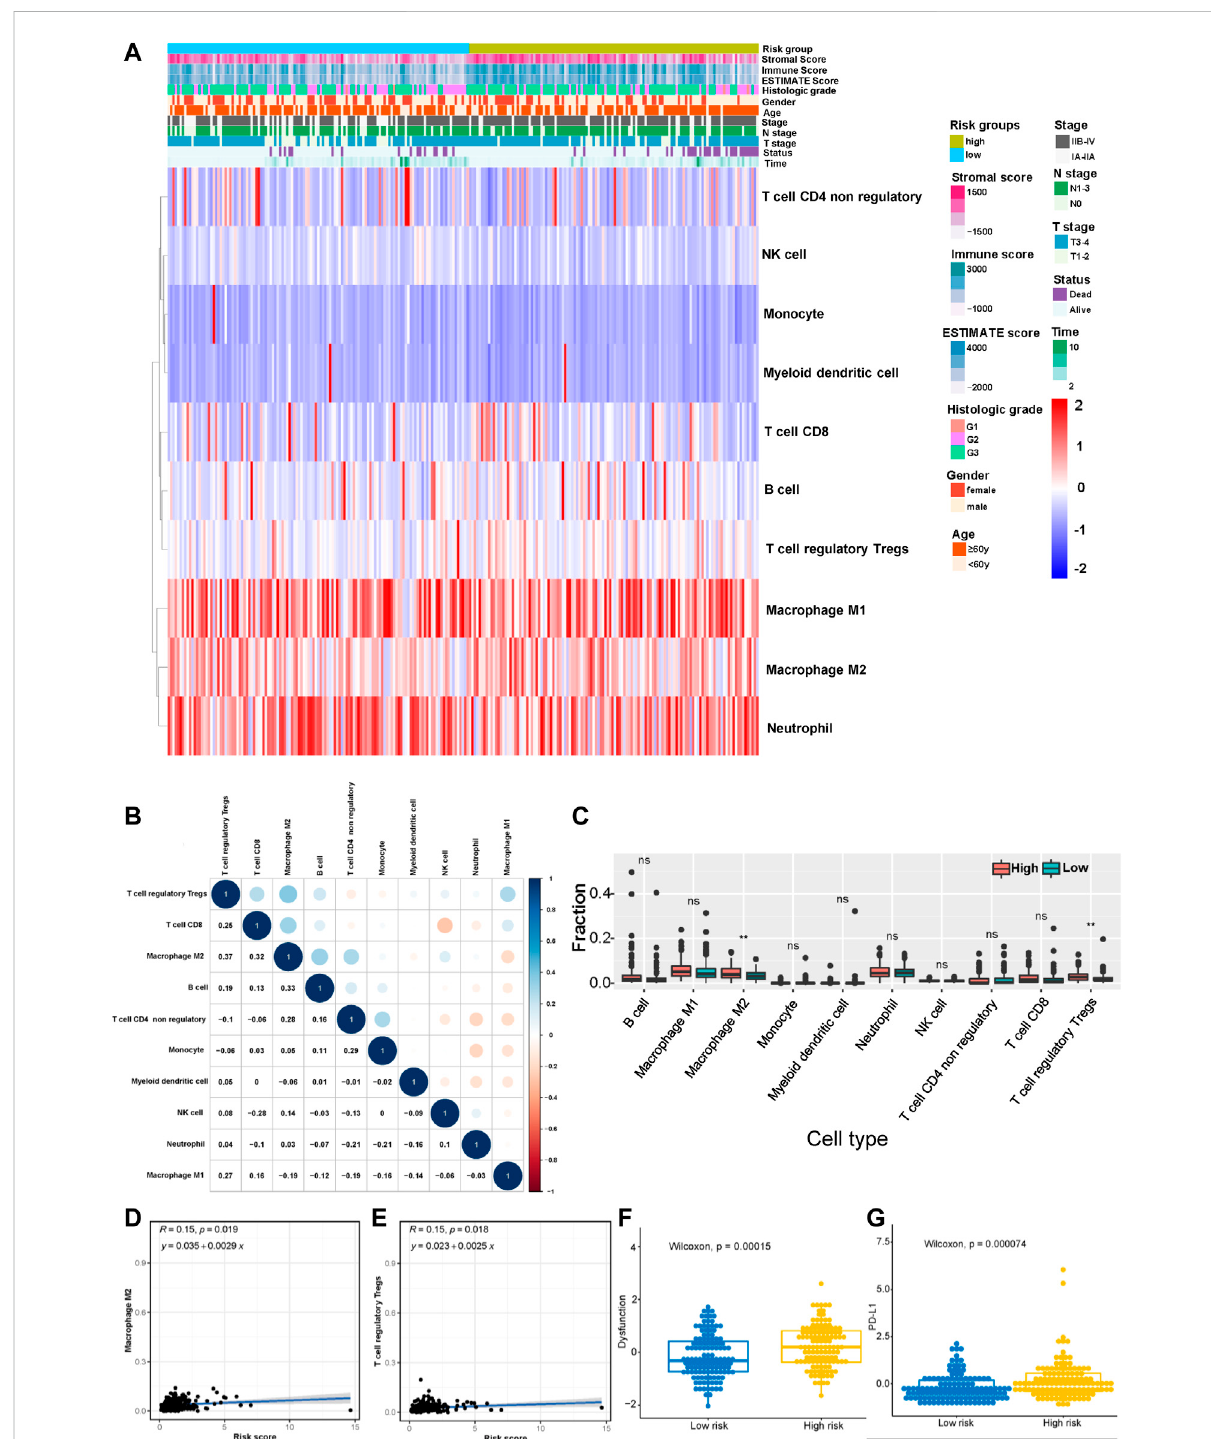
FIGURE 7 Correlation between the risk model and the immune status of the tumor microenvironment (TME). (A) Heatmap showing the distribution of clinical features and immune cell in fi ltration. (B) Correlation between 10 tumor in fi ltrating immune cell types (red represents a negative correlation between two immune cell types and blue represents a positive correlation between two immune cell types; the larger the shape of the point, the strongerthecorrelation). (C) Thedistributionof10tumorin fi ltratingimmunecelltypesinthehigh-andlow-riskgroups(** p < 0.01).Correlation betweentheriskscoreandin fi ltratinglevelsofM2-typemacrophages (D) andTregs (E) . (F) TheT-celldysfunctionscoresinthehigh-riskandlow-risk groups calculated using the TIDE algorithm. (G) The expression of PD-L1 in the high- and low-risk